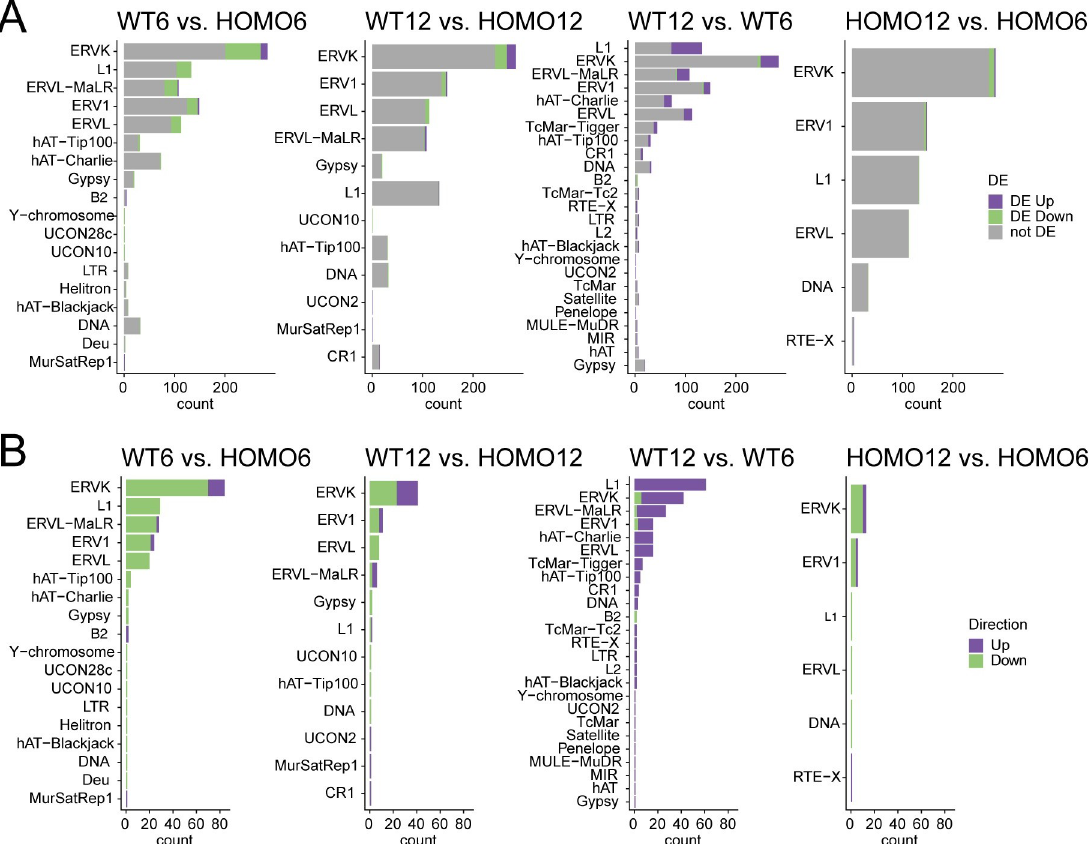
Fig 7. EHMT2 regulates transposable element subfamilies. ( A ) Bar charts depict the number of TE subfamilies that are up- or downregulated by EHMT2 in a given TE family (as written to the left) that shows changes in the contrasts indicated at the top. ( B ) Bar charts depict the number of TE subfamilies that are up- or downregulated by EHMT2 in a given TE family (as written to the left) that shows changes in the contrasts indicated at the top.